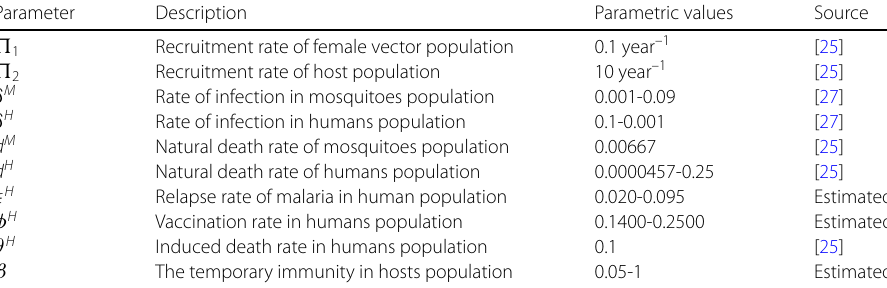
Table 2 The description of parameters along with parametric values of the system (3.1)